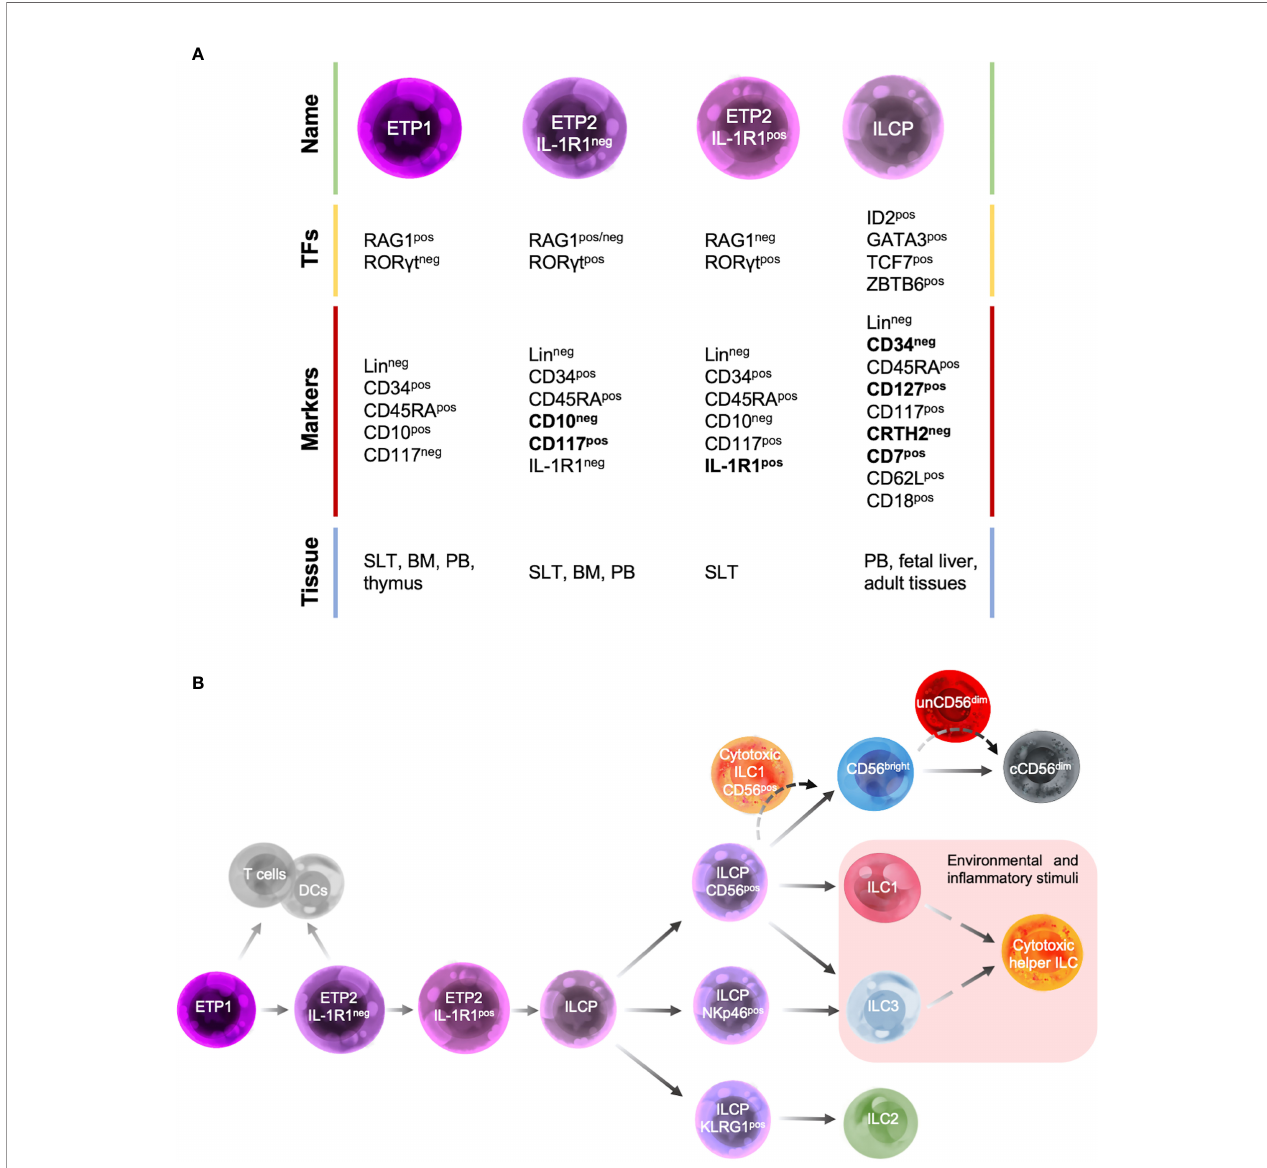
FIGURE 2 | Human ILC developmental stages. (A) Summary table of the main transcription factors (TFs), marker expression and tissue localization of common precursors/progenitors. (B) Schematic representation of different stages of human ILC-poiesis starting from the early tonsillar progenitors (ETPs), that still retain the ability to give rise to T cells and dendritic cells (DCs), to ILC precursor (ILCPs) that branches into progenitors with restricted differentiation potential and give rise to different mature ILC subsets. Dashed lines indicate the hypothetic developmental pathways of unconventional cytotoxic ILC